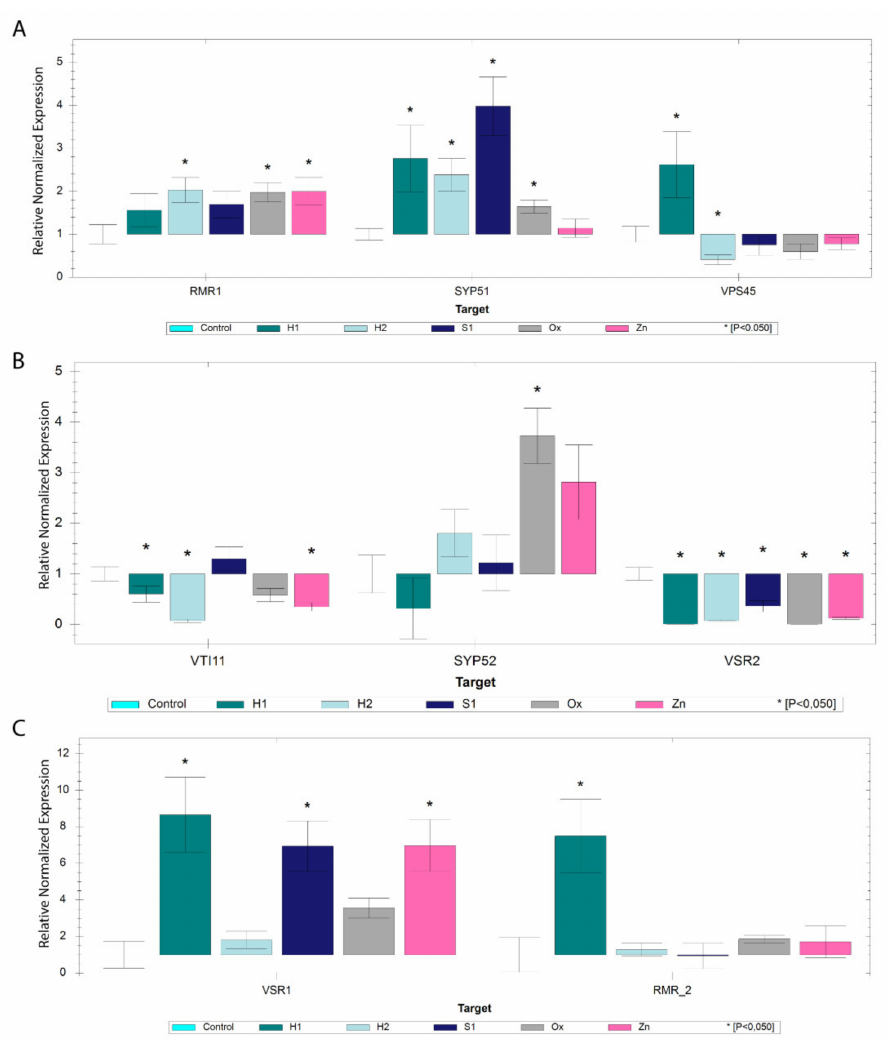
Figure 5. Expression analysis by qRT-PCR of genes involved in vacuolar routes. ( A ) Bar chart analysis of AtRMR1 , AtSYP51 and AtVPS45 genes involved in trafficking to the protein storage vacuole in different stress conditions relative to control. ( B ) Bar chart analysis of AtVSR2 , AtVTI11 and AtSYP52 genes involved in trafficking to the protein storage vacuole in different stress conditions relative to control. ( C ) Bar chart analysis of AtRMR2 and AtVSR1 genes involved in trafficking to the protein storage vacuole in different stress conditions relative to control. * indicates statistically experimental values ( p <